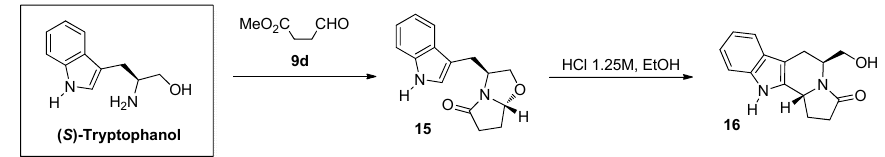
Scheme 4. Synthesis of compound 16 .